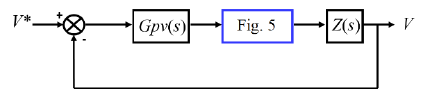
Figure 9. Average value model of the outer voltage loop of the proposed system.